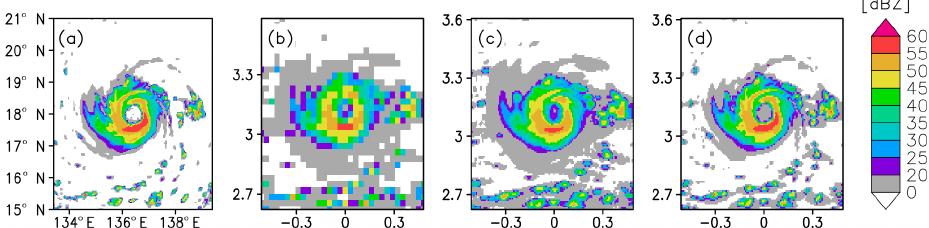
Figure 8. Radar reflectivity (dBZ) near the surface in the typhoon mature stage (00:00UTC, 5 August 2015) for (a) the truth, (b) bw20bs20,